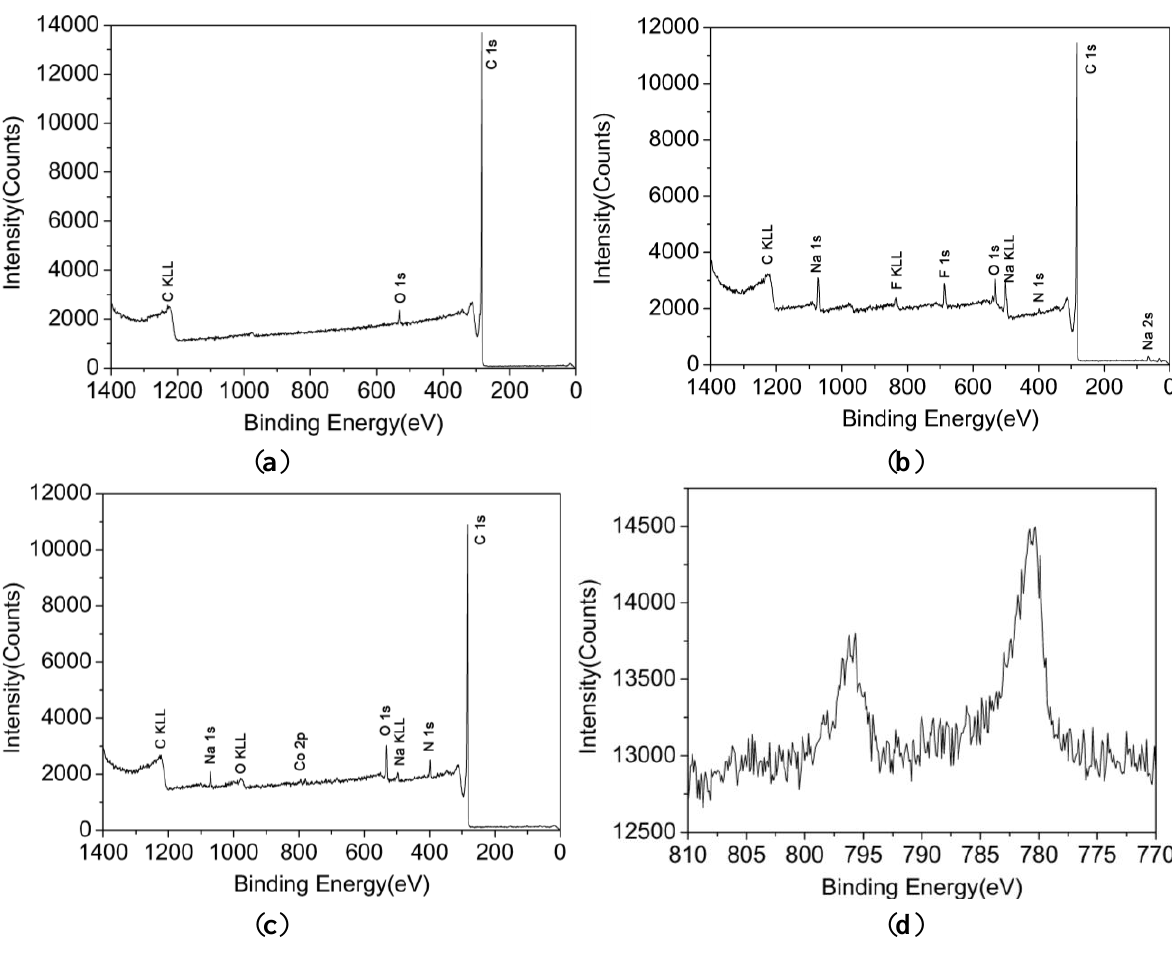
Figure 2. ( a ) XPS spectra of CNFs; ( b ) XPS spectra of AN-CNFs; ( c ) XPS spectra